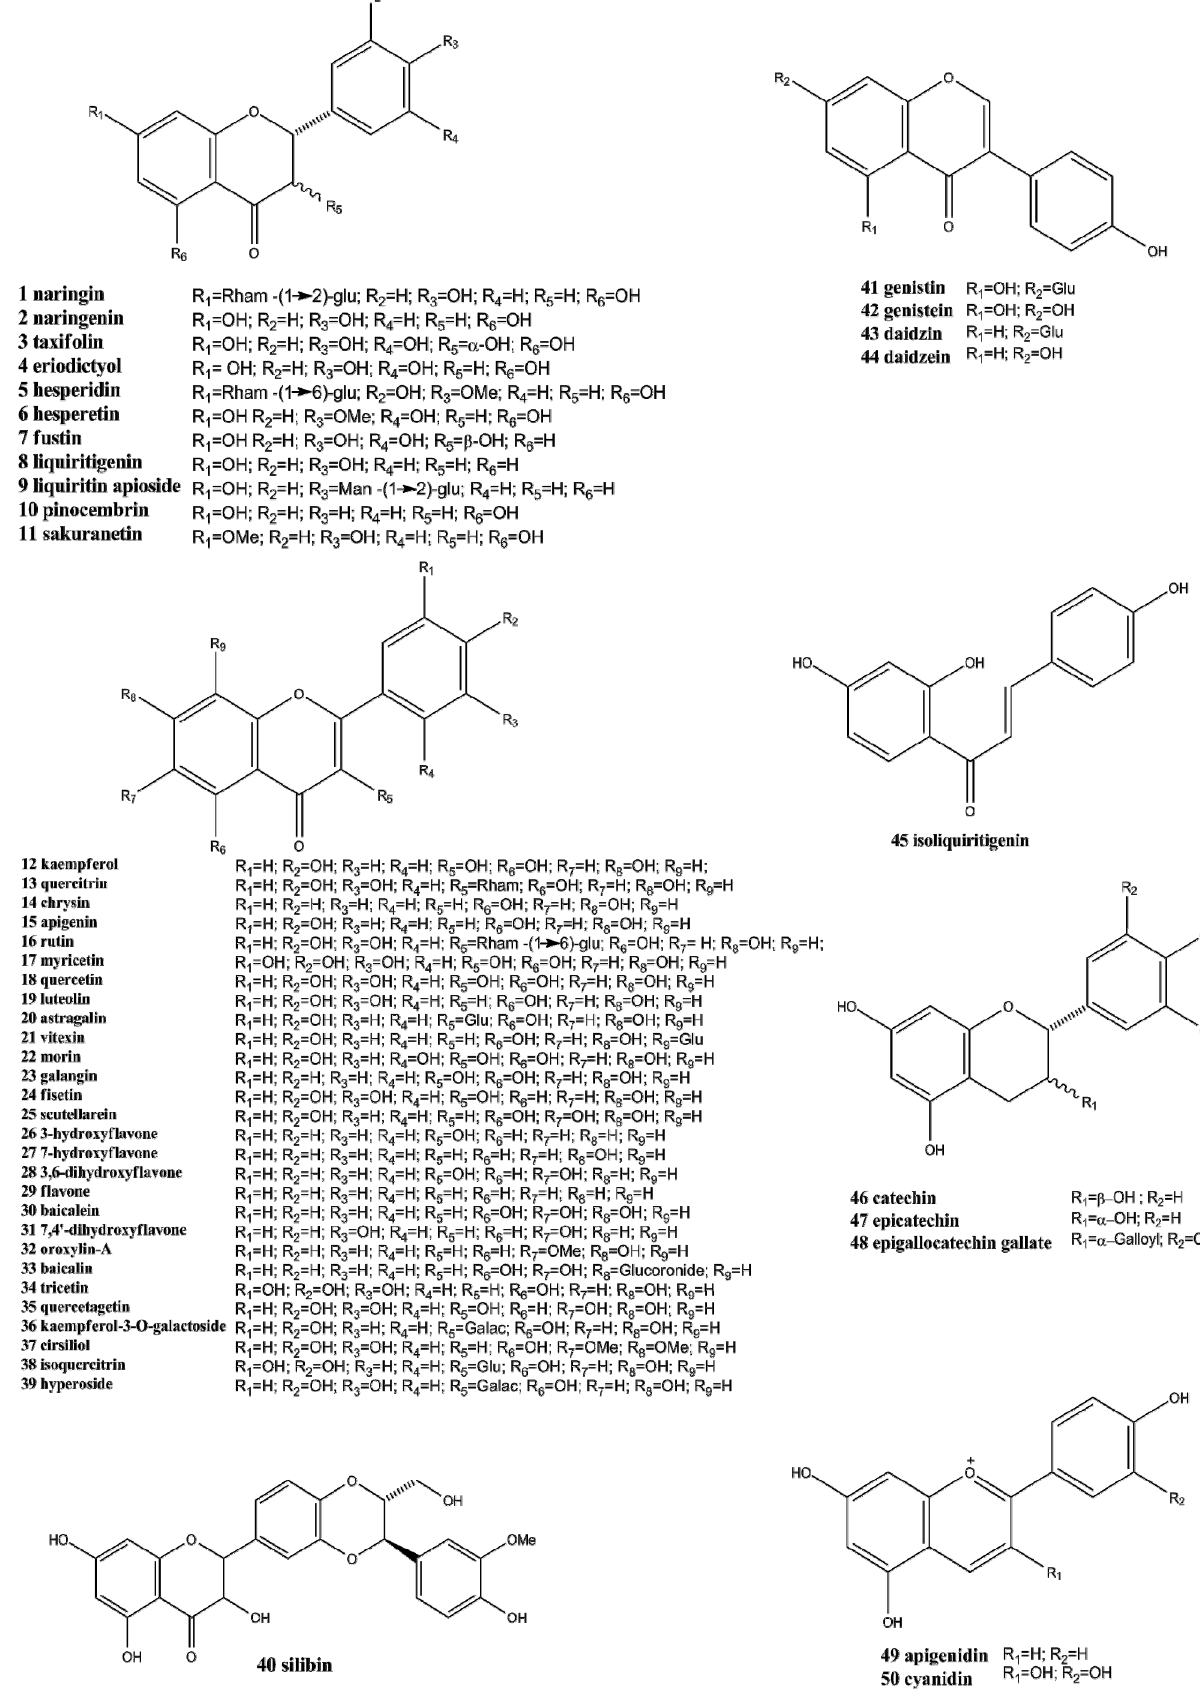
Figure 2. Chemical structures of flavonoids 1 – 50